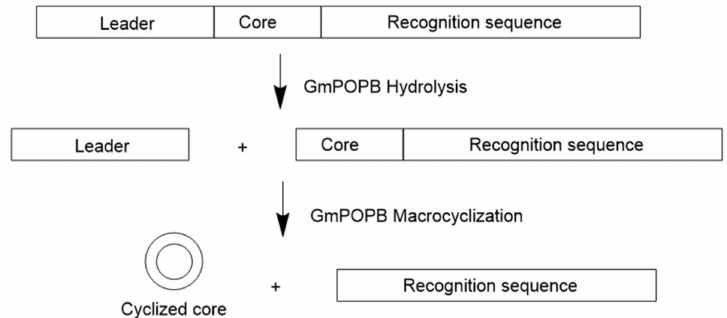
Figure 3. Schematic of prolyl oligopeptidase (POPB) catalyzed proteolysis and cyclization. GmPOPB is the POPB from Galerina marginata species. Adapted from Reference